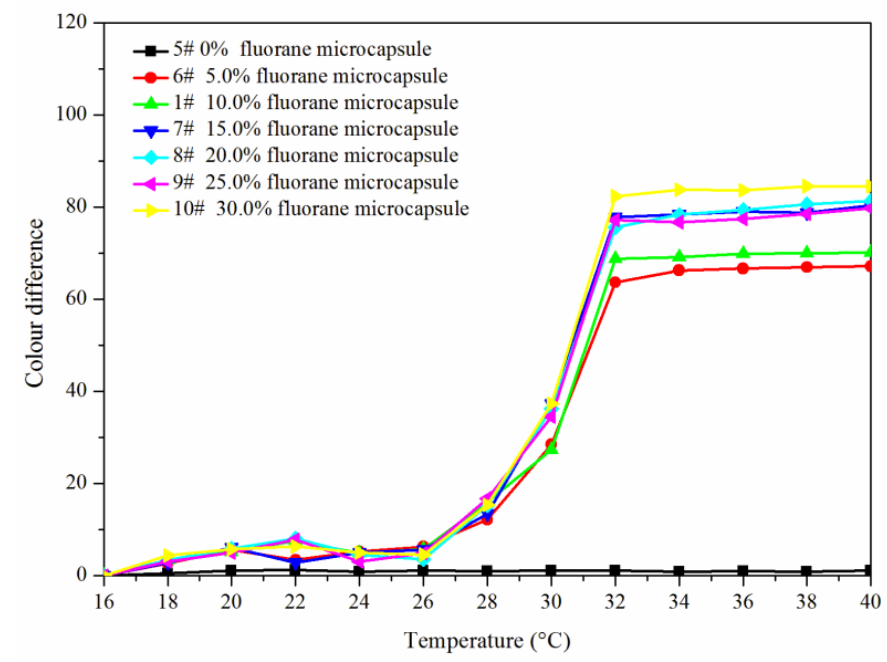
Polymers 2022 , 14 , x FOR PEER REVIEW